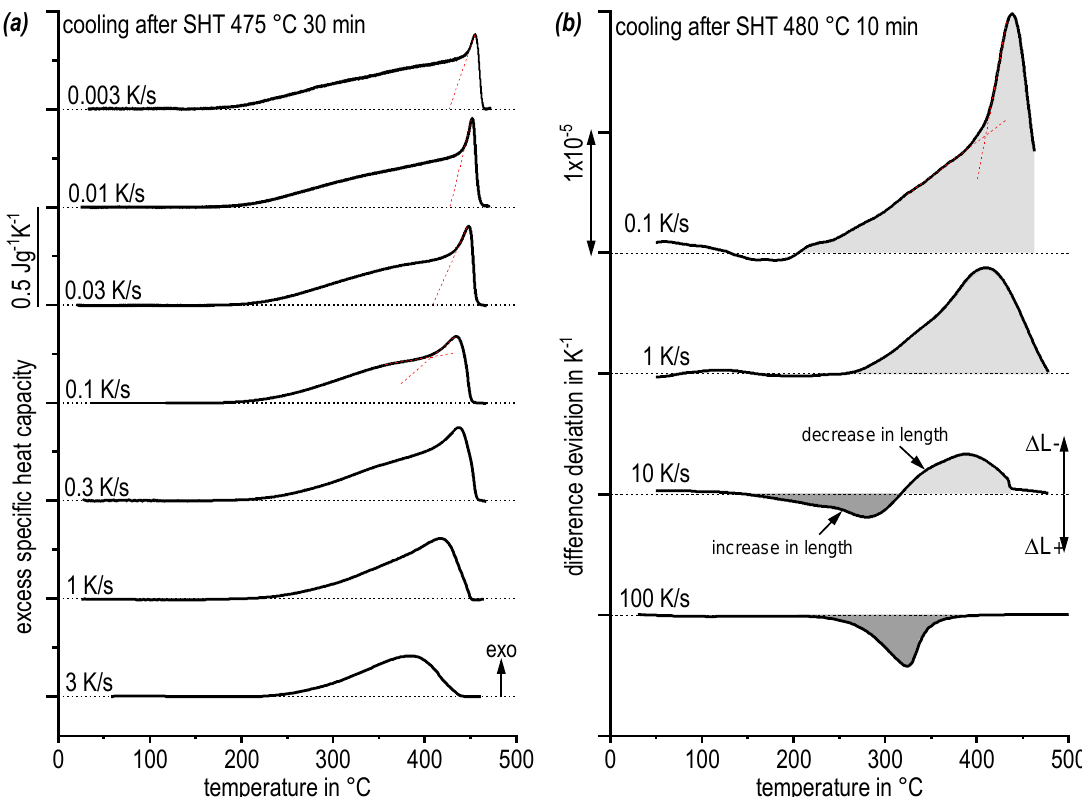
Figure 6. Cooling curves of alloy 7068 after solution annealing: ( a ) DSC and ( b ) differential dilatometry.